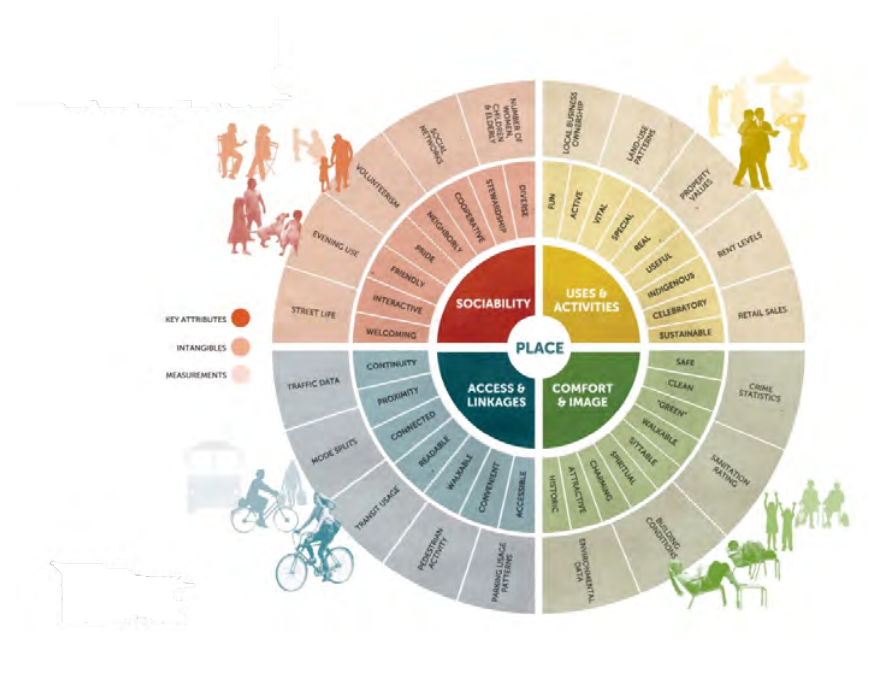
Figure 1. Shows the place diagram developed by PPS (PPS,